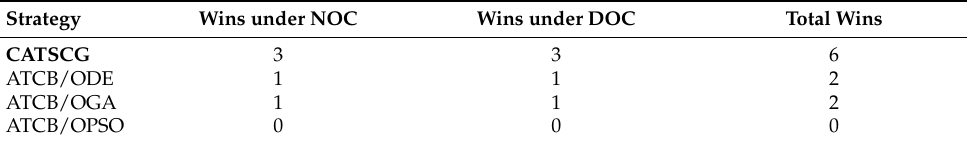
Table 6. Summary of the pairwise Wilcoxon signed-rank test over the values of ISE for the adaptive controller